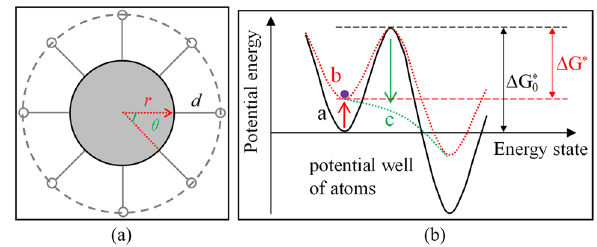
Fig. 3 Schematic diagrams showing a the nanocurvature effect of a nanowire; b the suppressed energy barrier of atoms (curve a → b, ΔG 0* → ΔG * ) as driven by nanocurvature effect, and the soft mode or instability of atomic vibration (curve b → c, ΔG * → 0) as driven by